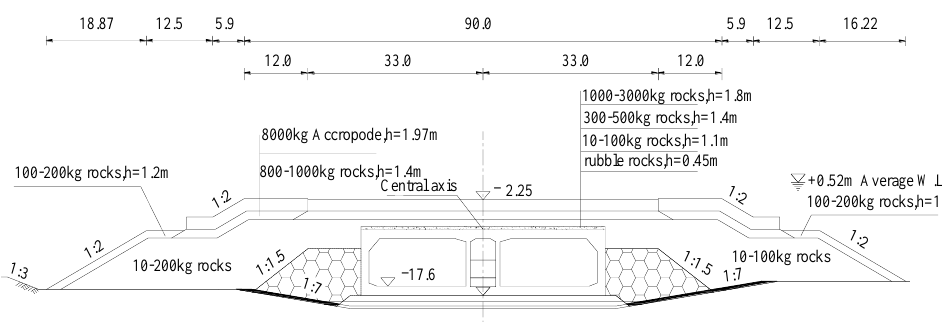
Figure 2. Section of overburden of immersed tunnel (unit: m).